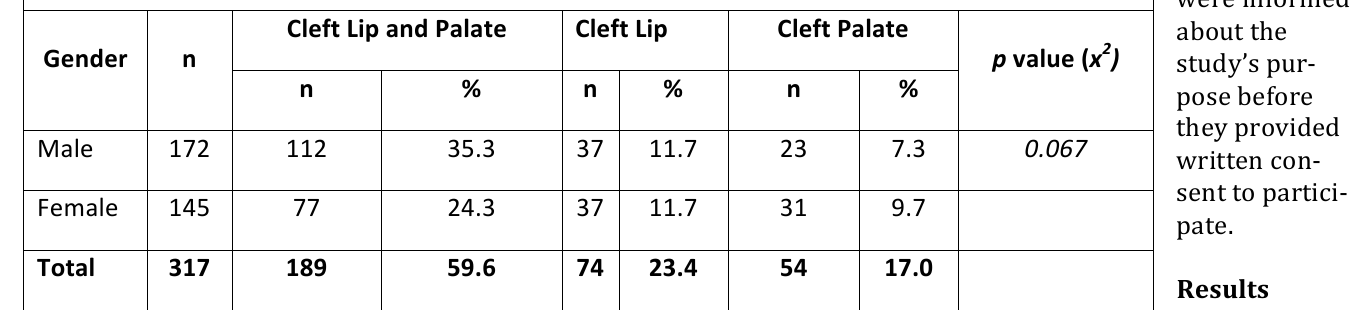
Table 1. Distribution of cleft lip and/or palate according to extension and gender. Gender